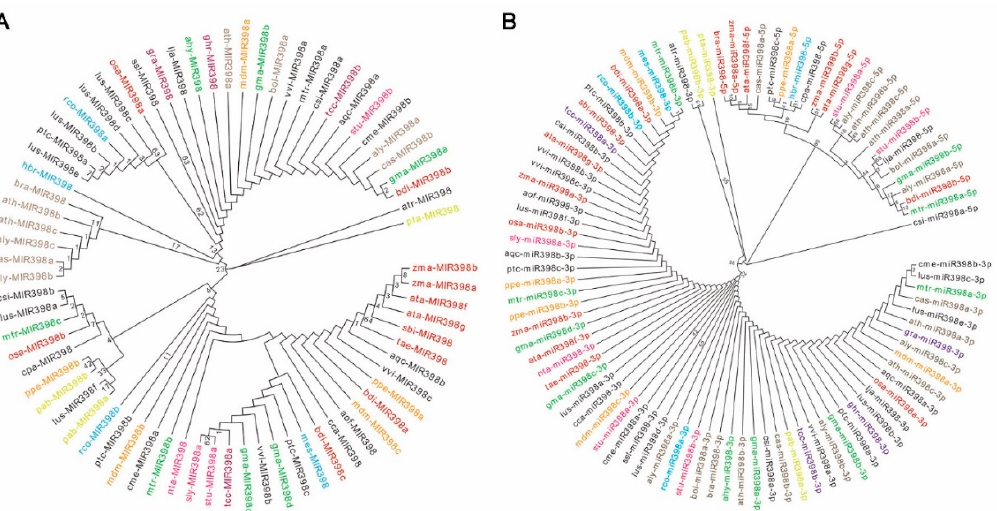
Figure 1. Phylogenetic analysis and sequence alignment of microRNA398 (miR398) precursor and mature sequences. ( A ) Phylogenetic analysis of the 73 miR398 precursors from 39 plant species, ranging from gymnosperms to eudicots. ( B ) Phylogenetic relationships among 93 mature miR398 sequences. Letters of the same color represent the same species. The dendrogram was constructed using MEGA7 software by the maximum-likelihood method with 1000 bootstraps. Pinus taeda is at the root of the evolutionary tree. ahy, Arachis hypogaea ; aly, Arabidopsis lyrata ; aof, Asparagus officinalis